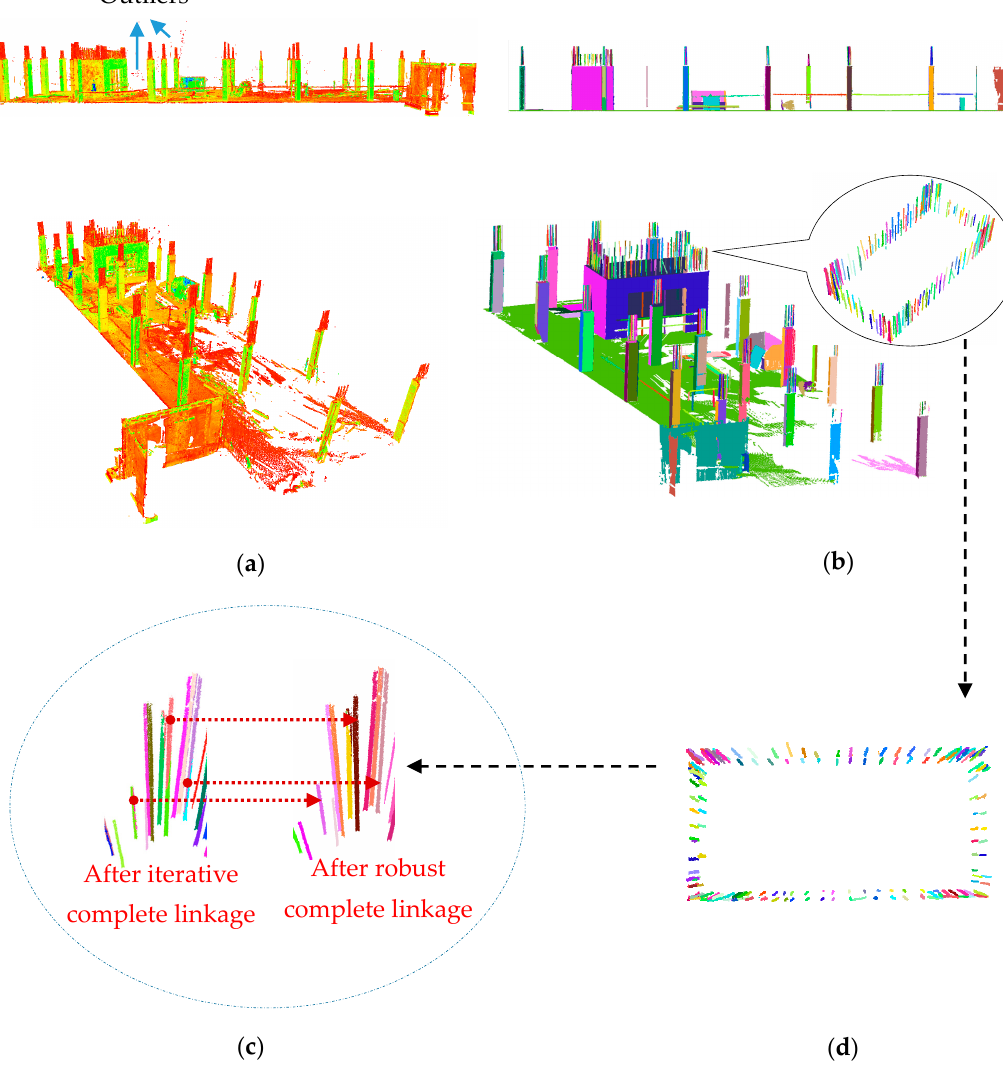
Figure 10. ( a ) Point cloud captured from Epoch 1 (colour represents intensity); ( b ) robust planar and linear segmentation results (each colour represents one segment); ( c ) rebar segmentation before and after the robust complete linkage algorithm; and ( d ) top-view of the rebar (linear feature) segmentation of the elevator shaft.